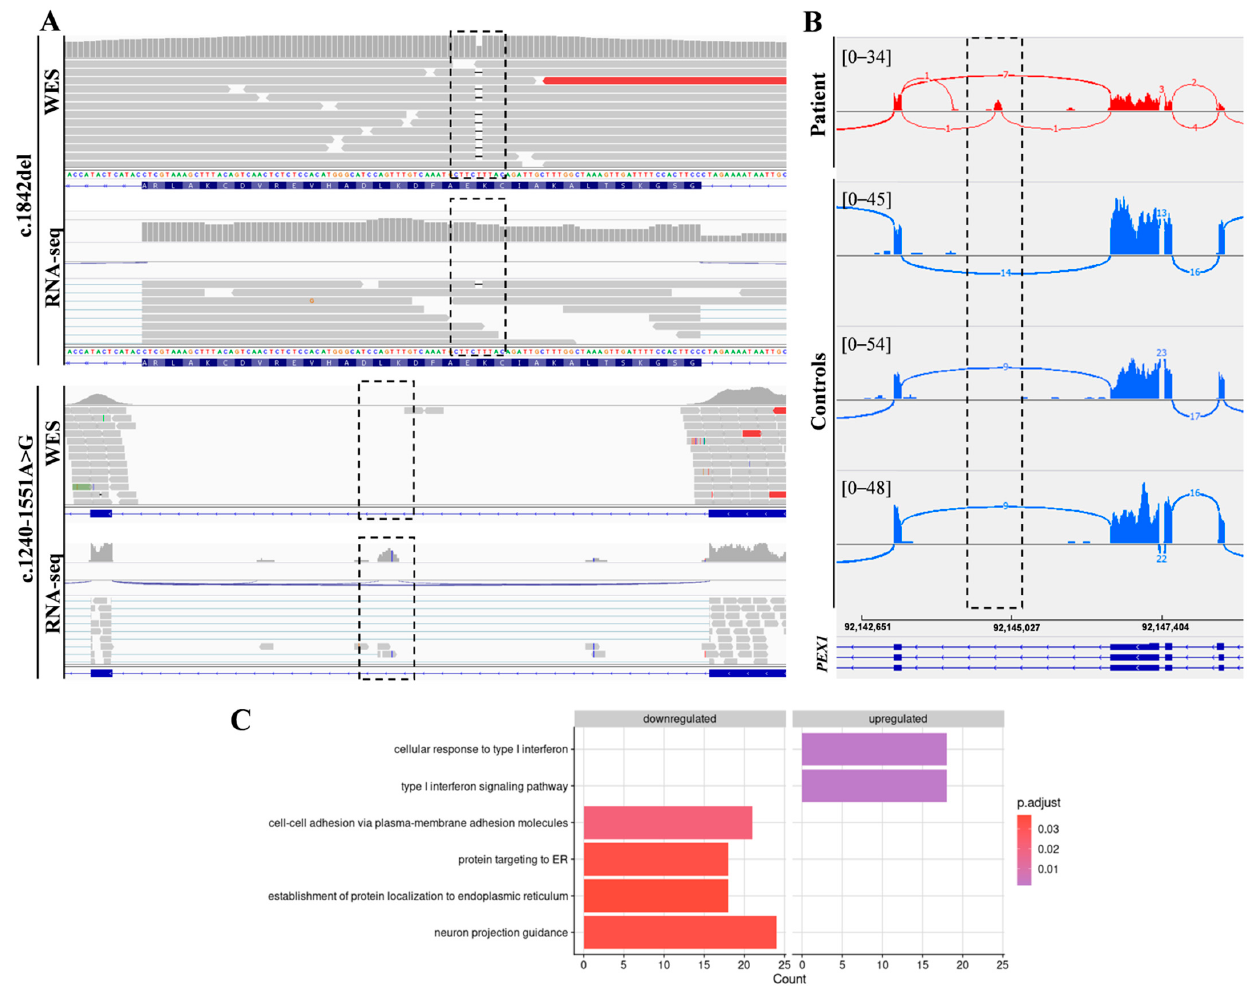
Figure 2. Combined WES and RNA-seq analysis identified PEX1 heterozygous variants. ( A ) The analysis of DNA and RNA mapped reads identified two heterozygous variants in PEX1 gene. The c.1842del variant was identified by WES, while the c.1240-1551A>G deep intronic substitution was not covered by WES but was captured by RNA-seq. ( B ) Sashimi plots showing the aberrant incorporation of an intronic sequence into PEX1 mRNA in patient fibroblasts compared to controls. ( C ) Gene Ontology (GO) analysis of differentially expressed genes showed significantly enriched GO terms for the indicated biological processes.